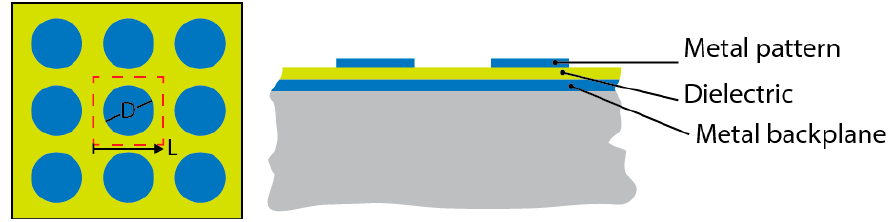
Figure 2. Schematic of a metamaterial